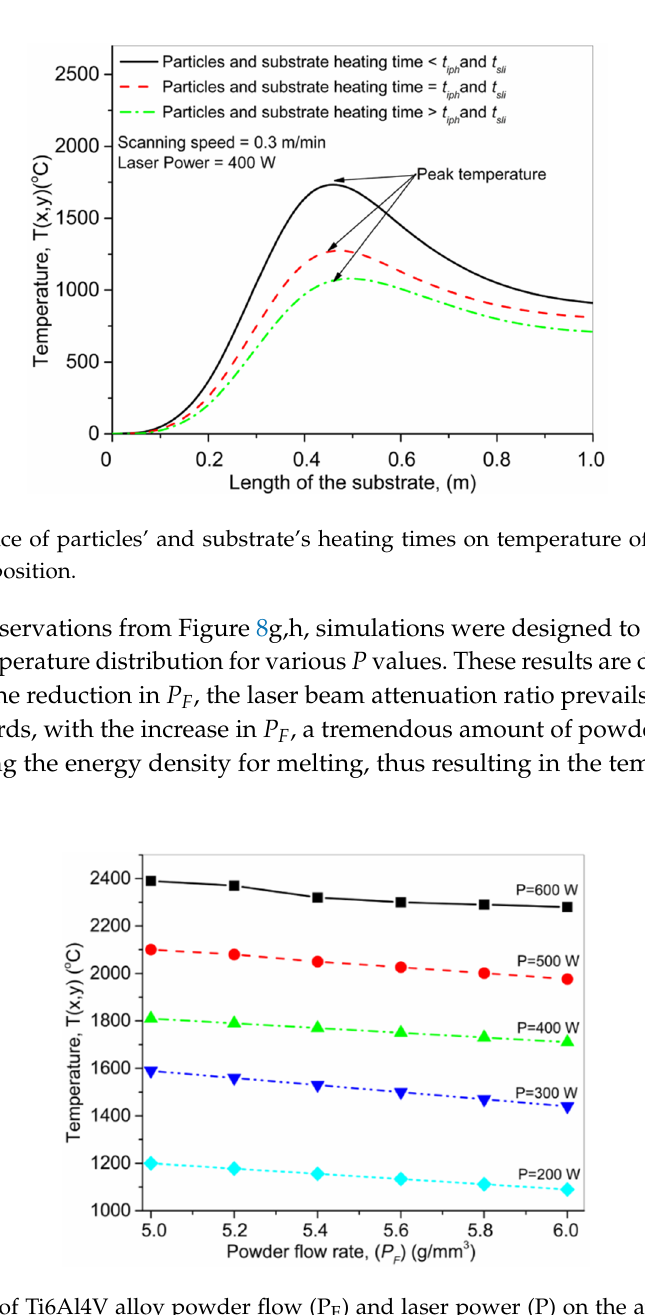
Figure 11. Effect of Ti6Al4V alloy powder stream on average maximum temperature at the substrate when P = 400 W, v l = 0.3 m/min, and P F = 5.0 (g/mm 3 ). 5. Conclusions This contribution involves the development of mathematical models for three-jet powder flow and temperature distribution on the substrate’s surface in the case of the LMD process. Initially, the Gaussian powder stream was simulated. Following on, the powder flow was added coaxially with the moving laser beam to analyze the effect of powder addition on the temperature distribution of the substrate. Additionally, an analytical formula to estimate the laser beam energy attenuation has been obtained. The particles’ inflight and within the melt-pool heating times were controlled to avoid excessive heating and possible transformation into vapors and plasma. The following results have been deduced based on the current model. The focal point position plays an essential role in determining the configuration of the powder stream. An increase in the distance above the focal point position will gradually transform the powder stream from Gaussian to Transition, and next to Annular distribution. The primary operating parameters, including laser scanning speed, laser power, and powder flow rate, play a critical role in determining the temperature value at the substrate. An inverse relationship has been found between the laser scanning speed and the powder flow rate versus temperature distribution. Besides, the laser power presented a direct relationship with the temperature value.